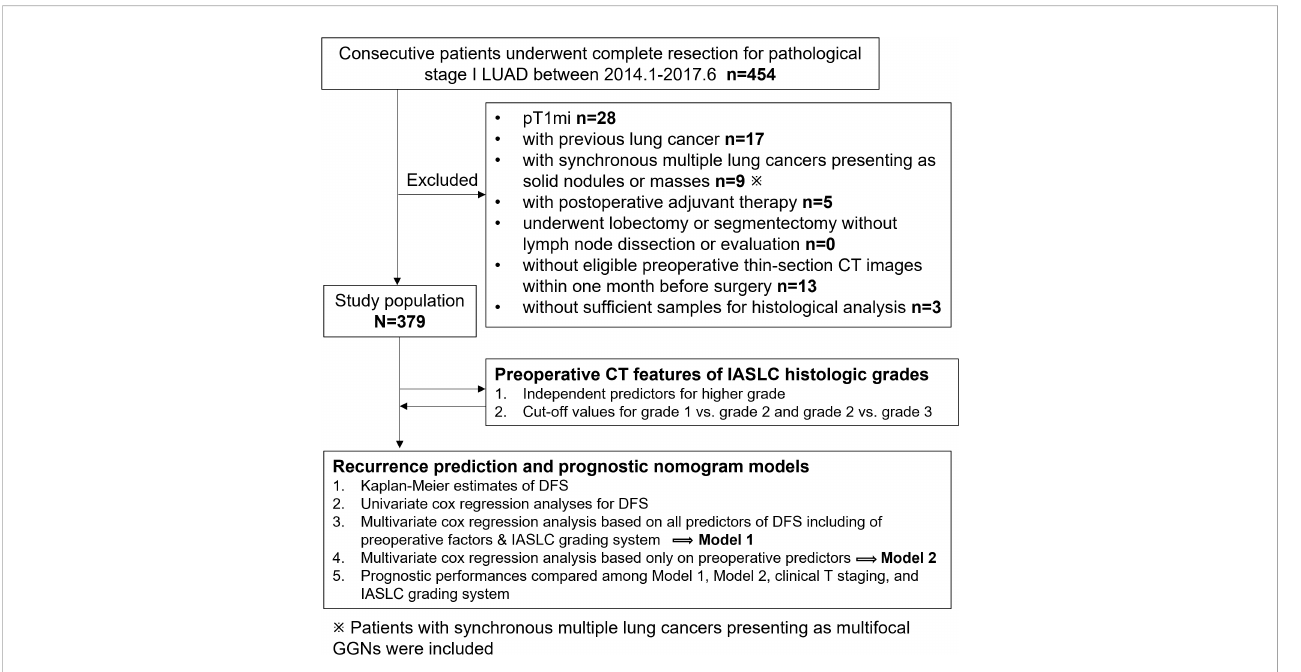
FIGURE 1 Flow chart of patient selection and study procedure. LUAD, lung adenocarcinoma; DFS, disease-free survival; GGN, ground glass